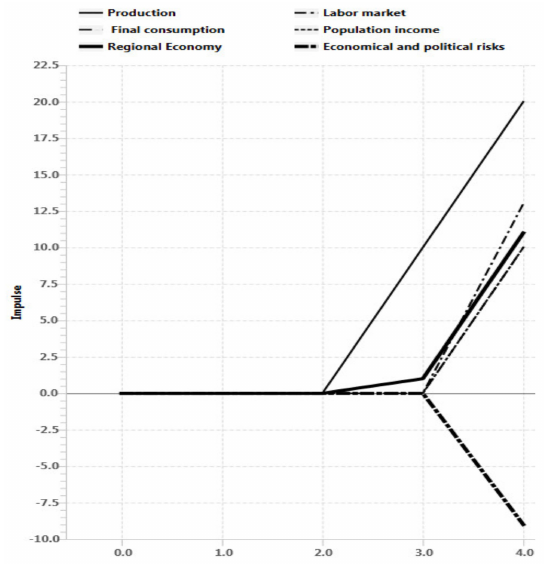
Figure 8. The graph of impulse processes at the selected vertices V1–V5, V16 Scenario "Improving the conditions of higher education system in the region" disturbing momentum q10 = +